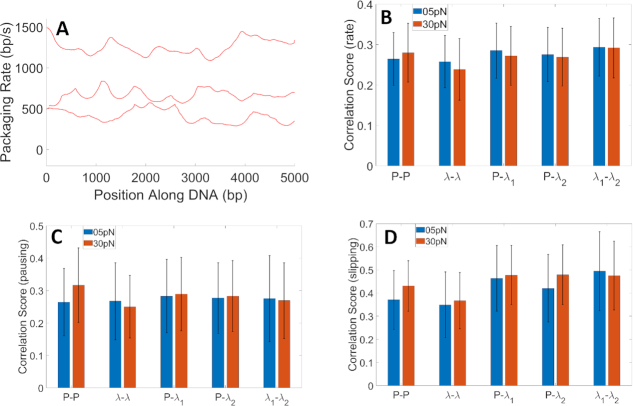
Correlation analyses. (A) Examples of measured packaging rate versus position along DNA measured with the linear plasmid DNA sequence. (B) Correlations analyzed between rate versus position along DNA measured in one event and that measured in other events when packaging either the same sequence or different sequences. ‘Correlation score’ is defined in the methods section. ‘P’ refers to the linear plasmid DNA sequence, λ to the control phage DNA, λ1 to one 10 kbp section of the control DNA, and λ2 to another 10 kbp section of the control DNA (see ‘Materials and Methods’ section). ‘P-P’ indicates correlation score for pairs of events where P was packaged. ‘λ-λ’ refers pairs of events where λ was packaged. ‘P-λ1’ and ‘P-λ2’ refer to correlations between P datasets and λ1 or λ2 datasets. ‘λ1-λ2’ refers to correlations between λ1 and λ2 datasets. Results were determined from 134 recorded events at 5 pN and 45 recorded events at 30 pN for the linear plasmid sequence and 80 events at 5 pN and 50 events at 30 pN for the control DNA. Error bars for all plots indicate one standard deviation. (C) Correlations analyzed between pausing versus position measured in one event and that measured in other events, as in (B). Correlation score for pausing is defined in methods. (D) Correlations analyzed between slipping versus position measured in one event and that measured in other events, as in (B). Correlation score for slipping is defined in ‘Materials and Methods’ section.